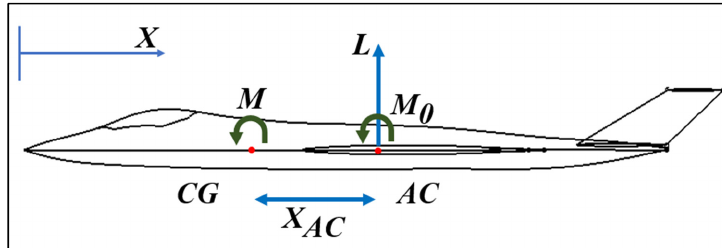
Figure 5. Force analysis of the aircraft.